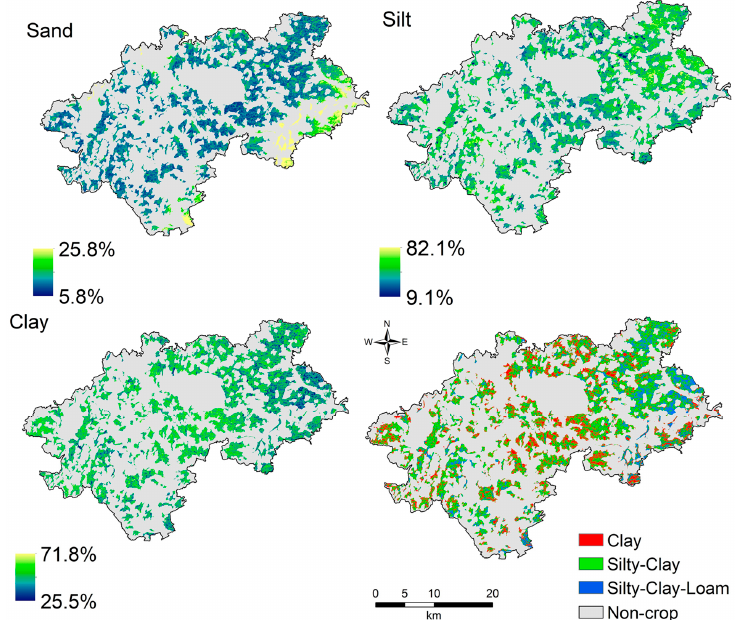
Figure 4. Estimated soil texture fractions (% of sand, silt, and clay) and WRB soil texture classes in 0–30 cm based on best-fitted machine learning models for the SA region.